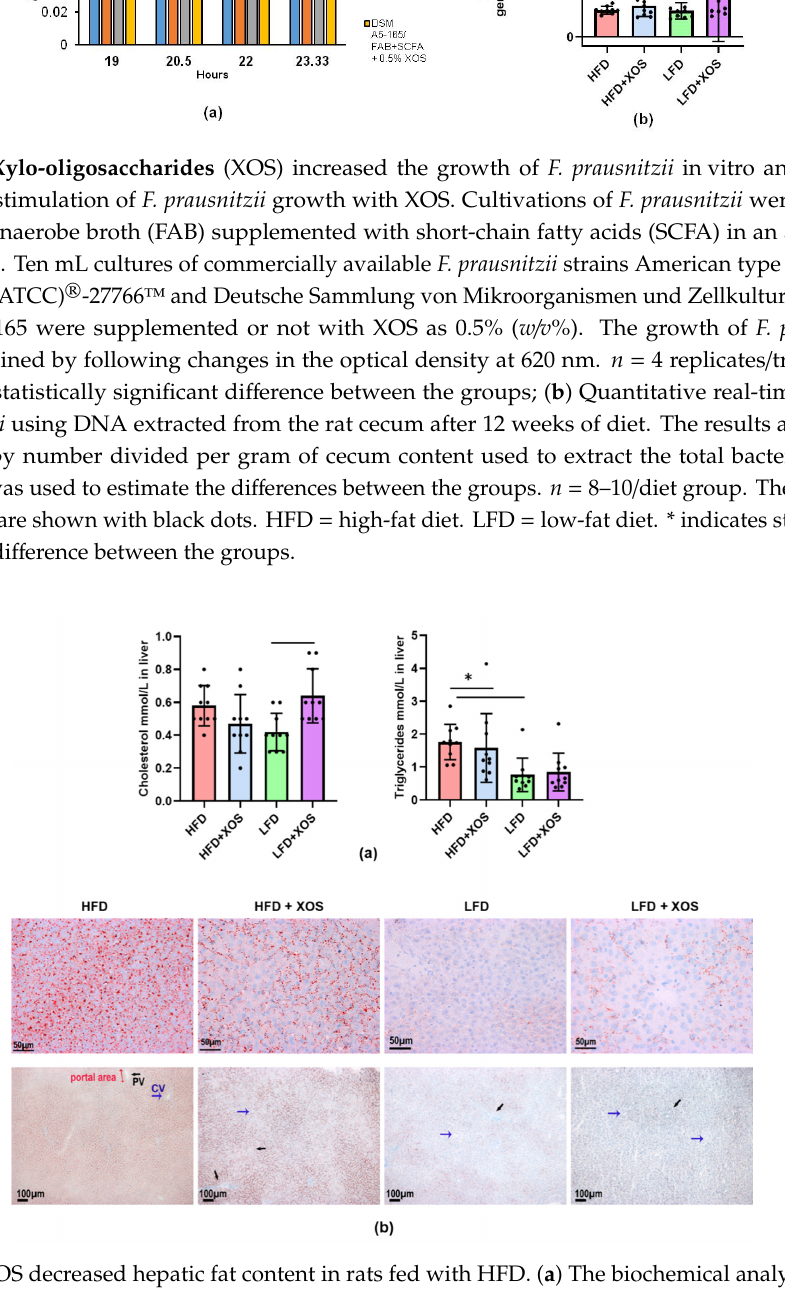
Figure 2. XOS decreased hepatic fat content in rats fed with HFD. ( a ) The biochemical analyses of the total hepatic cholesterol and triglyceride content. n = 8–10/diet group. The different data points are shown with black dots. * indicates statistically significant difference between the groups; ( b ) The frozen liver sections of the rats stained with Oil Red O. The scale bar in the upper images is 50 µM and in the lower images 100 µM. The histological images were taken with Olympus BX50 microscope and Colorview III camera using 40 x (Olympus UPlanFI, NA 0.75) and 10 x (Olympus UPlanFI NA 0.3) objectives. Blue arrows indicate central vein, which is abbreviated as CV in the lower image of the HFD. Black arrows indicate portal vein, which is abbreviated as PV in the lower image of the HFD.